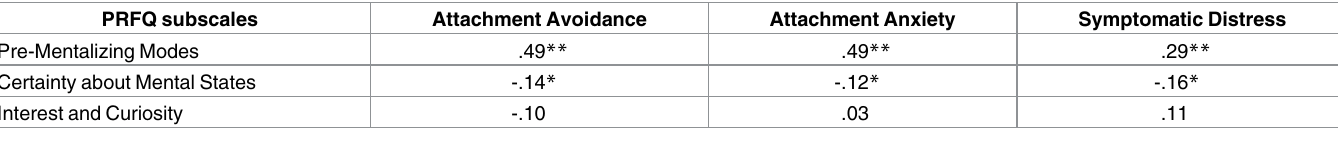
Table 3. Correlations among the PRFQ subscales, symptomatic distress, and maternal attachment in Study